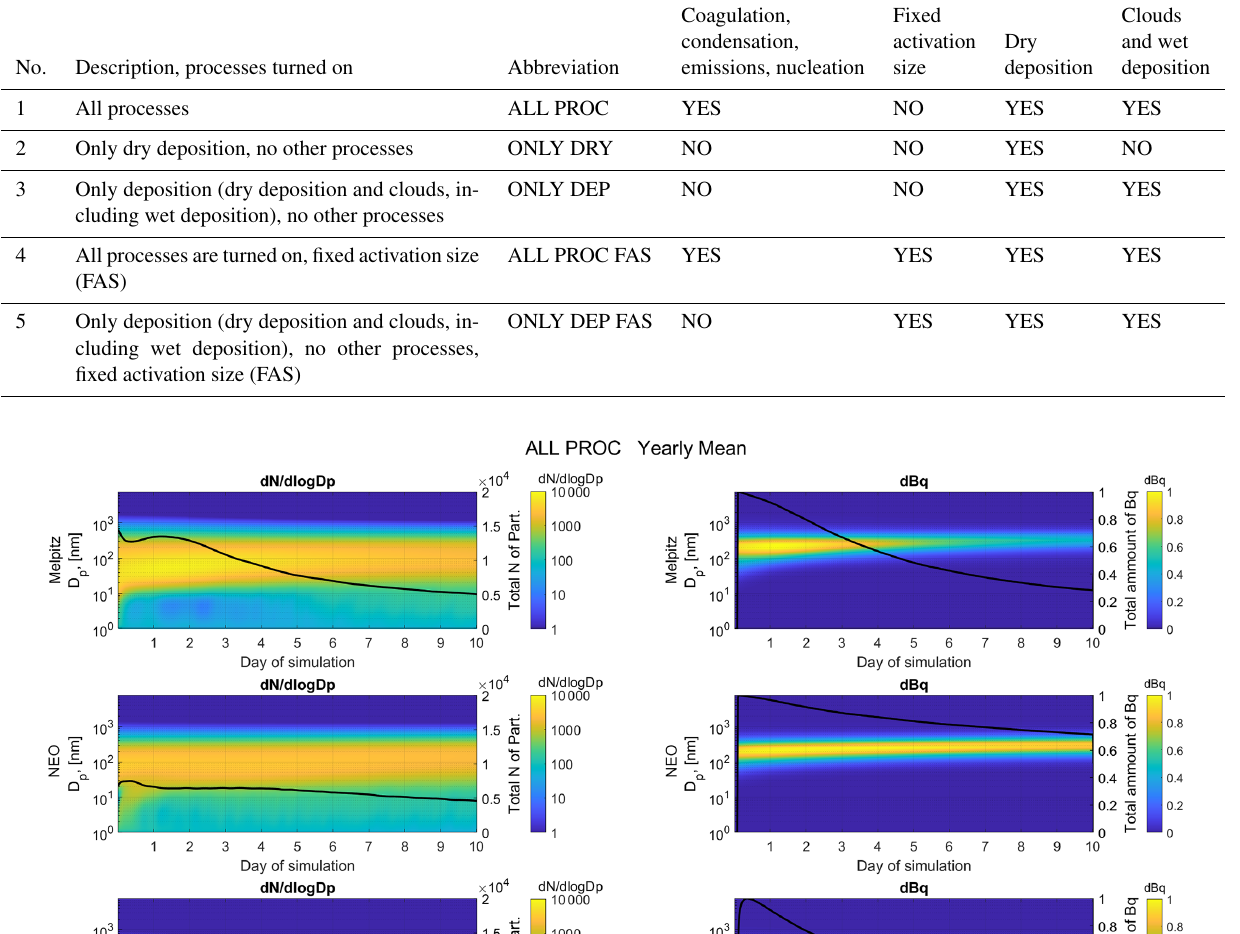
The evolution of the ambient PNSD of the aerosol and the size distribution of released 137 Cs (activity size distribution of the 137 Cs attached on the particles) is shown in Fig. 4. This plot shows the annual mean average of the first experiment where all processes are turned on, ALL PROC; 137 Cs is rep- resented as a Becquerel value normalized to the maximum value. The total particle number concentration and the total amount of 137 Cs attached on the particles are plotted as black lines in respective graphs (right-hand axes). The rows show Melpitz, NEO and Zeppelin, respectively, with d N/ dlog D p to the left and 137 Cs (Becquerel values) to the right. The de-